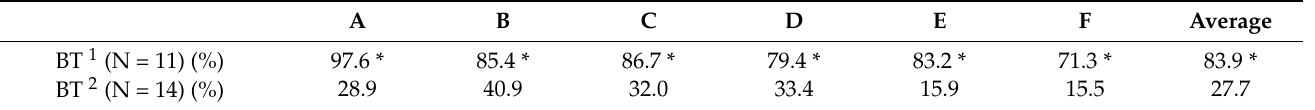
Table 4. Training dogs using exhaled breathing target samples has a higher diagnostic rate for lung cancer than training dogs using lung cancer samples in lung cancer group.